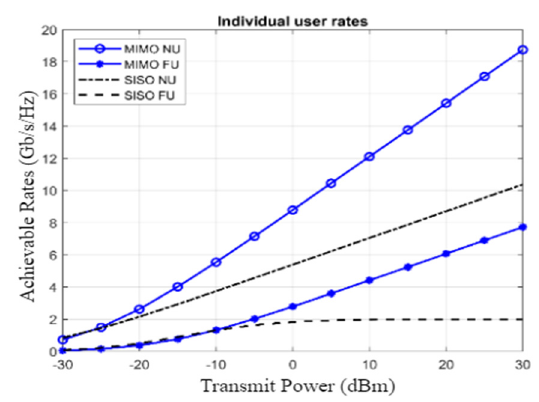
Figure 6. Rates vs. transmit power.